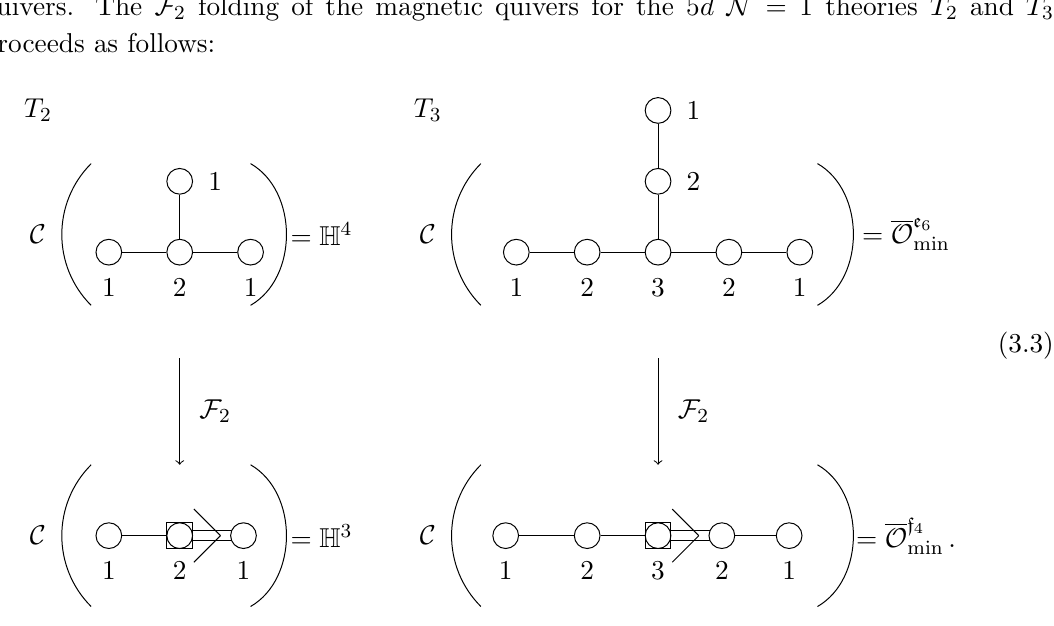
= 2 rank 1 theory. To N = N